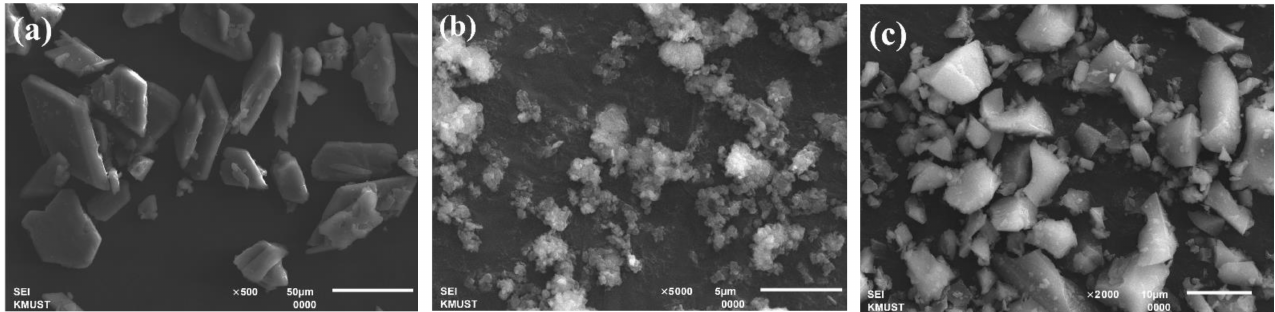
Figure 2. SEM images of ( a ) phosphogypsum; ( b ) red mud; and ( c ) slag.